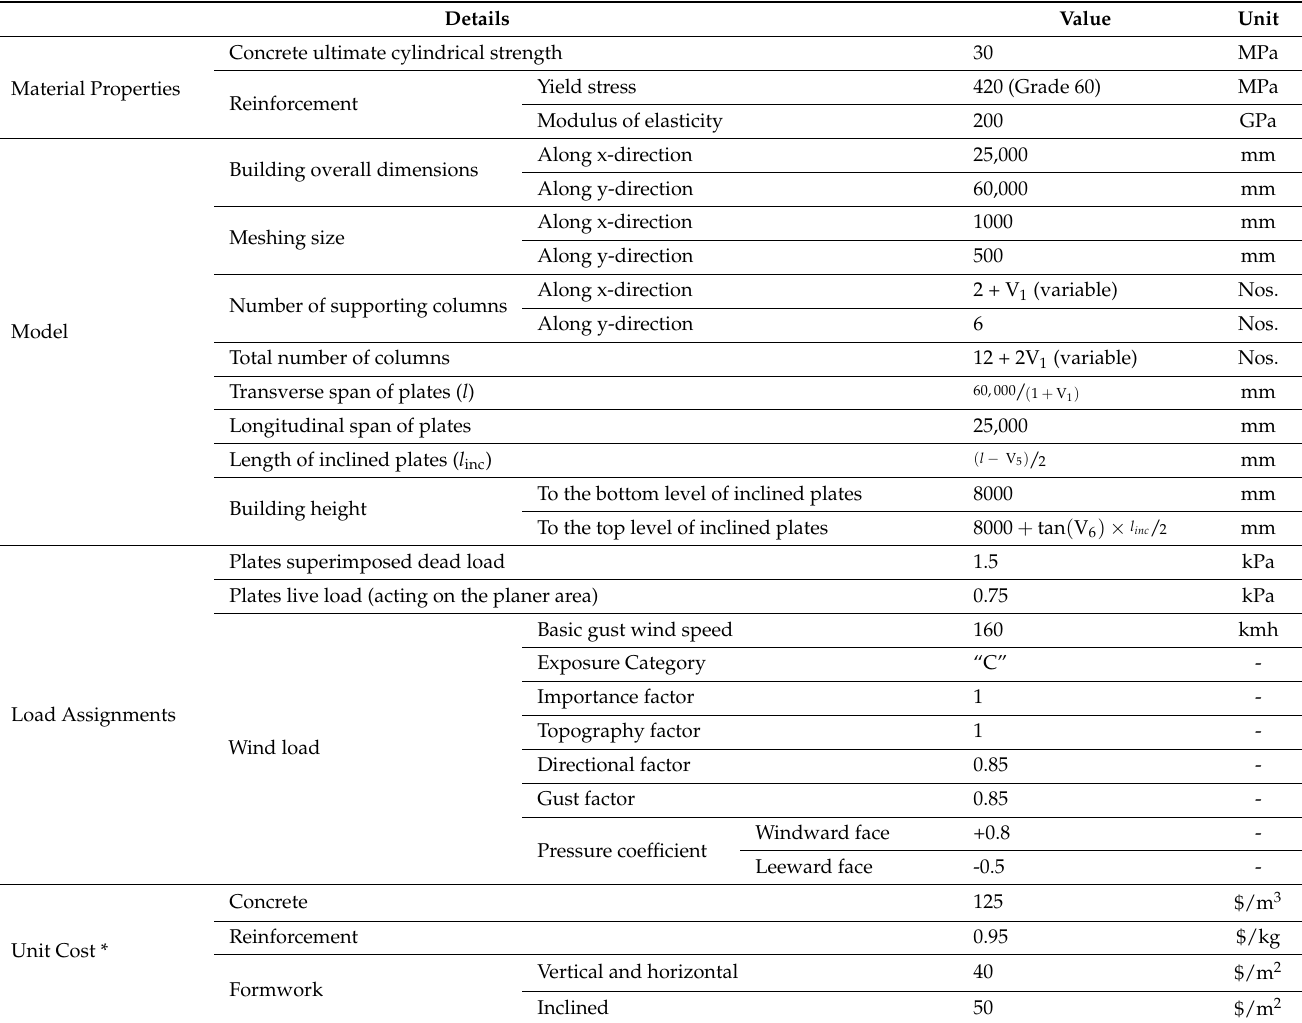
Table 22. Input data for the three-segment type folded plate roof building.